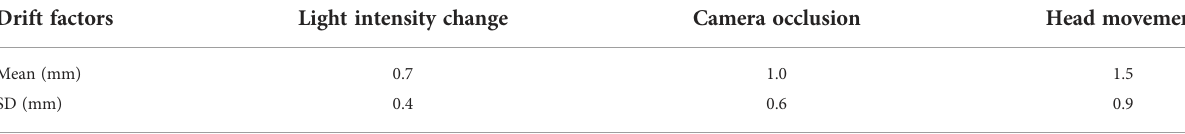
TABLE 4 The hologram drifts are caused by the light intensity change, camera occlusion, and head movement. Drift factors